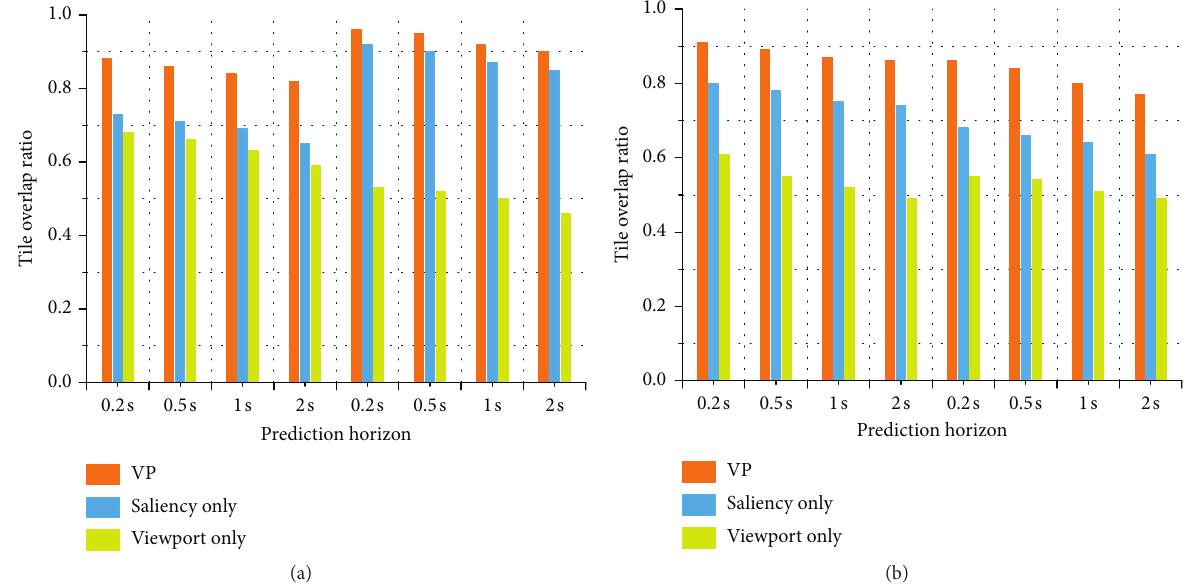
Figure 7: Prediction of the average tile overlap rate of the entire video at different time intervals. (a) Videos 1 and 2. (b) Videos 3 and 4.